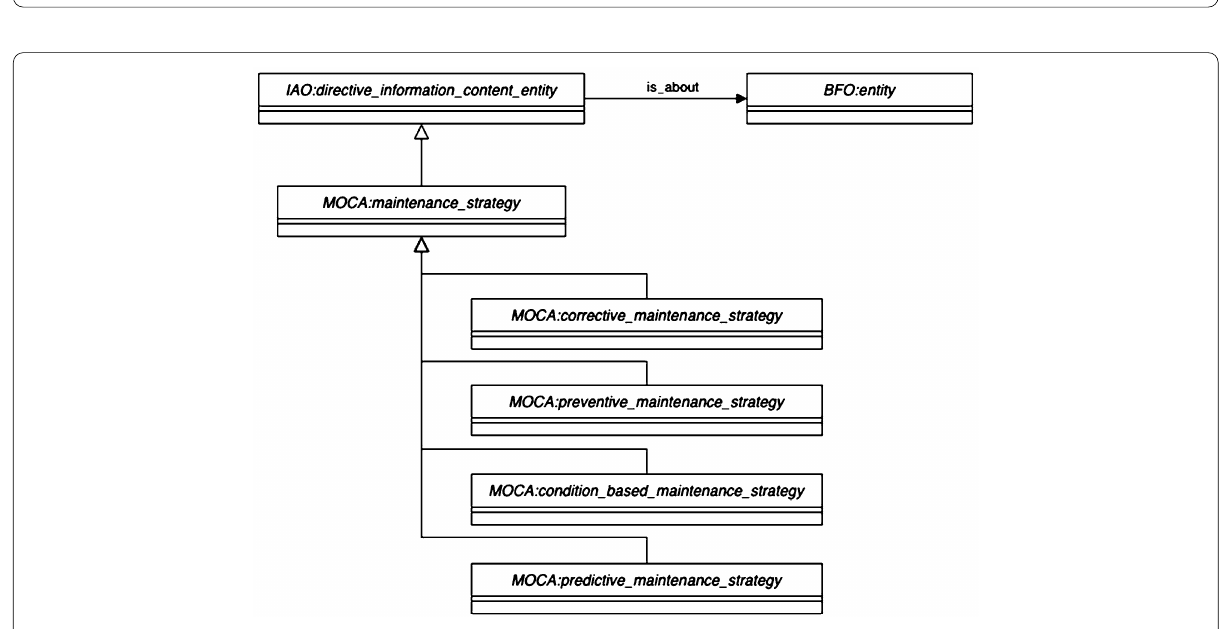
Figure 7 Maintenance strategy modelling in